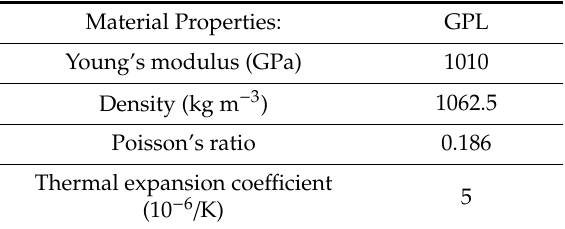
Table 6. Material properties of the GPL [110]. Material